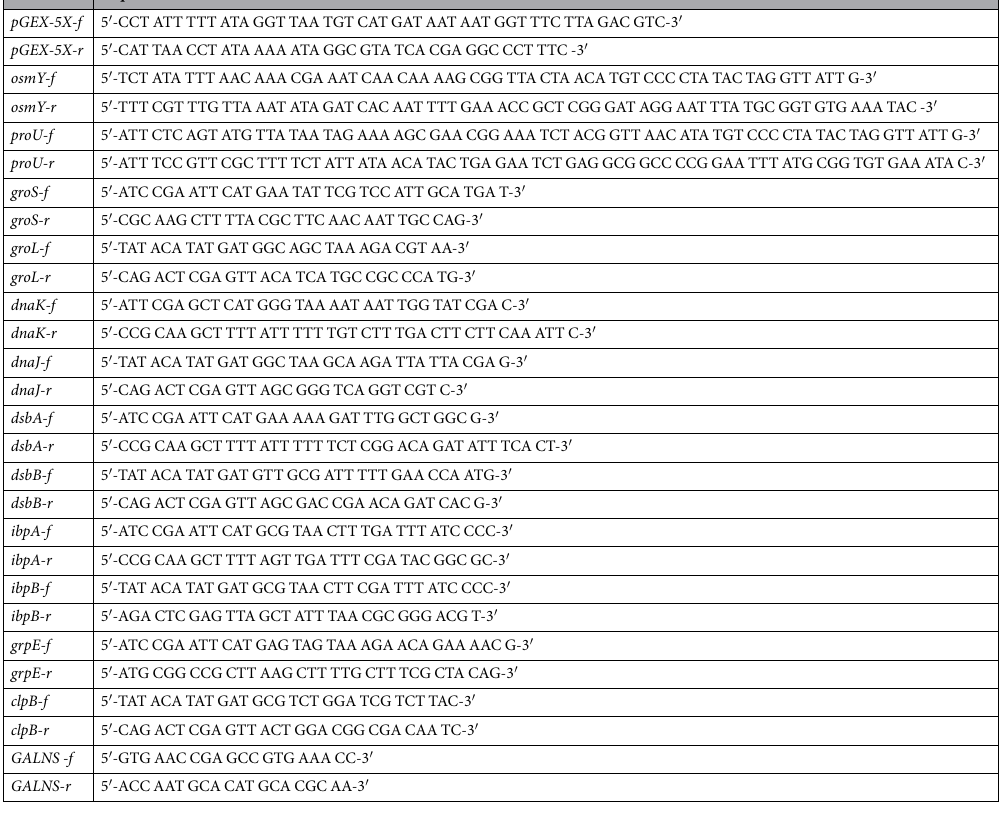
Table 3. Primers used in this